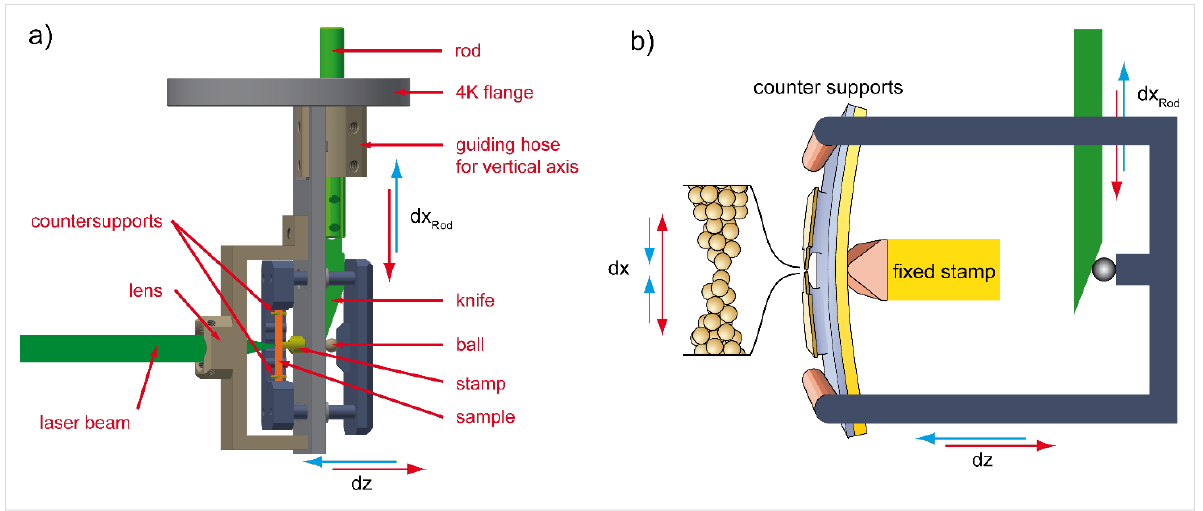
Figure 1: a) Schematics of the MCBJ mechanism. The sample is represented as the orange line and the junction is located in its center. b) Schematics of the movement scheme for clarification. The green-labeled parts indicate the vertical and the blue ones the horizontal movement.